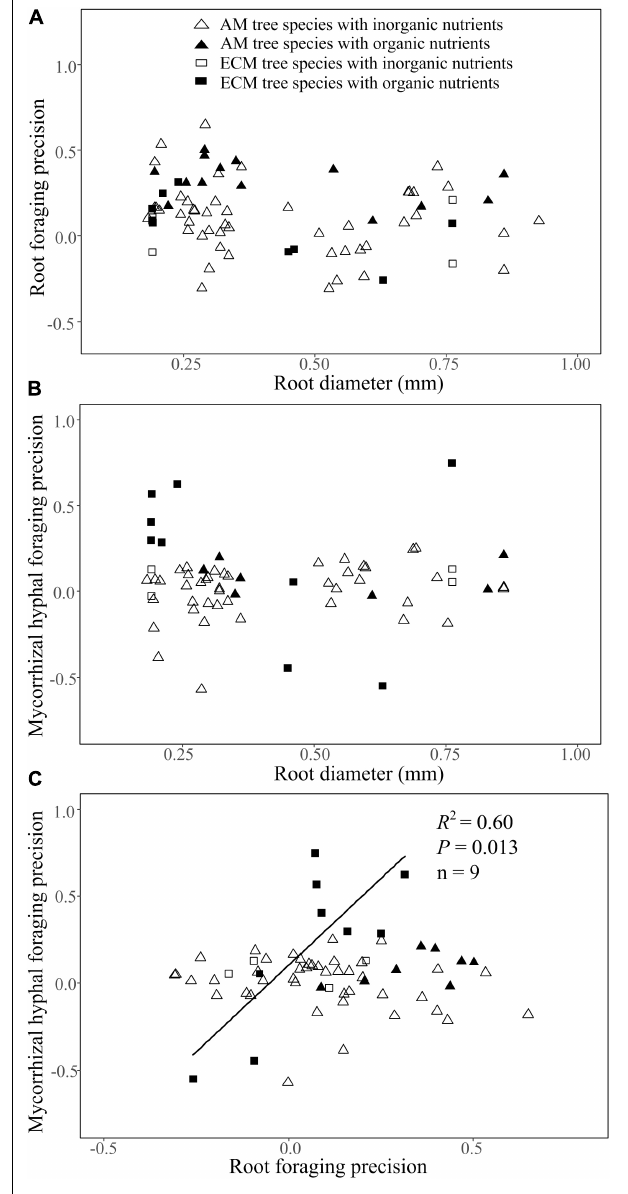
FIGURE 4 | The relationship of root diameter with root foraging precision (A) and mycorrhizal hyphal foraging precision (B) , and the relationship of root foraging precision with mycorrhizal hyphal foraging precision for AM and ECM woody species (c) in organic or inorganic nutrient patches based on the second dataset. Regression lines are shown when P < 0.05, and the regression information in (C) refers to ECM tree species supplied with organic nutrients heterogeneously